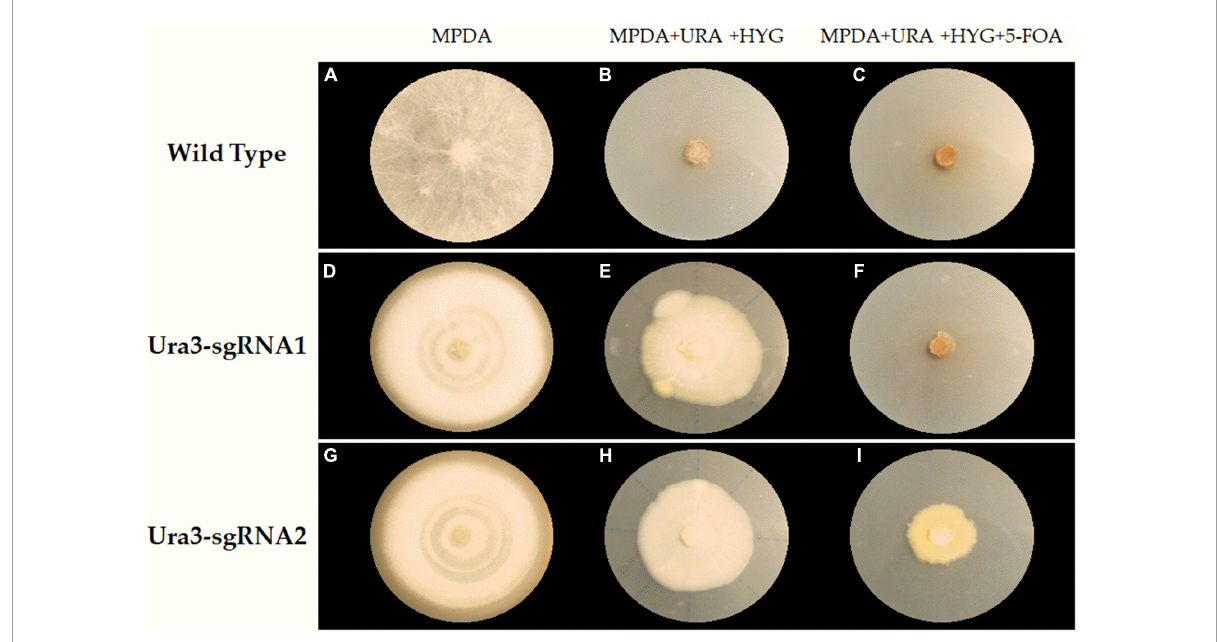
FIGURE5 The selection of transformants and mutants on a different medium plate. (A) Wilde type grown on MPDA; (B) wilde type grown on MPDA + URA + HYG; (C) wilde type grown on MPDA + URA + HYG + 5-FOA; (D) Ura3-sgRNA1 grown on MPDA; (E) Ura3-sgRNA1 grown on MPDA + URA + HYG; (F) Ura3-sgRNA1 grown on MPDA + URA + HYG + 5-FOA; (G) Ura3-sgRNA2 grown on MPDA; (H) Ura3-sgRNA2 grown on MPDA + URA + HYG; (I) Ura3-sgRNA2 grown on MPDA + URA + HYG + 5-FOA; Wild type, the wild type of Poria cocos strain; Ura3-sgRNA1, the transformant of pFC332-PcU6-Ura3-sgRNA1; Ura3-sgRNA2, the transformant of pFC332-PcU6-Ura3-sgRNA2; MPDA, the modified PDA medium; MPDA + URA + HYG, MPDA medium with hygromycin and uracil. MPDA + URA + HYG + 5-FOA, MPDA medium with hygromycin, 5-FOA, and